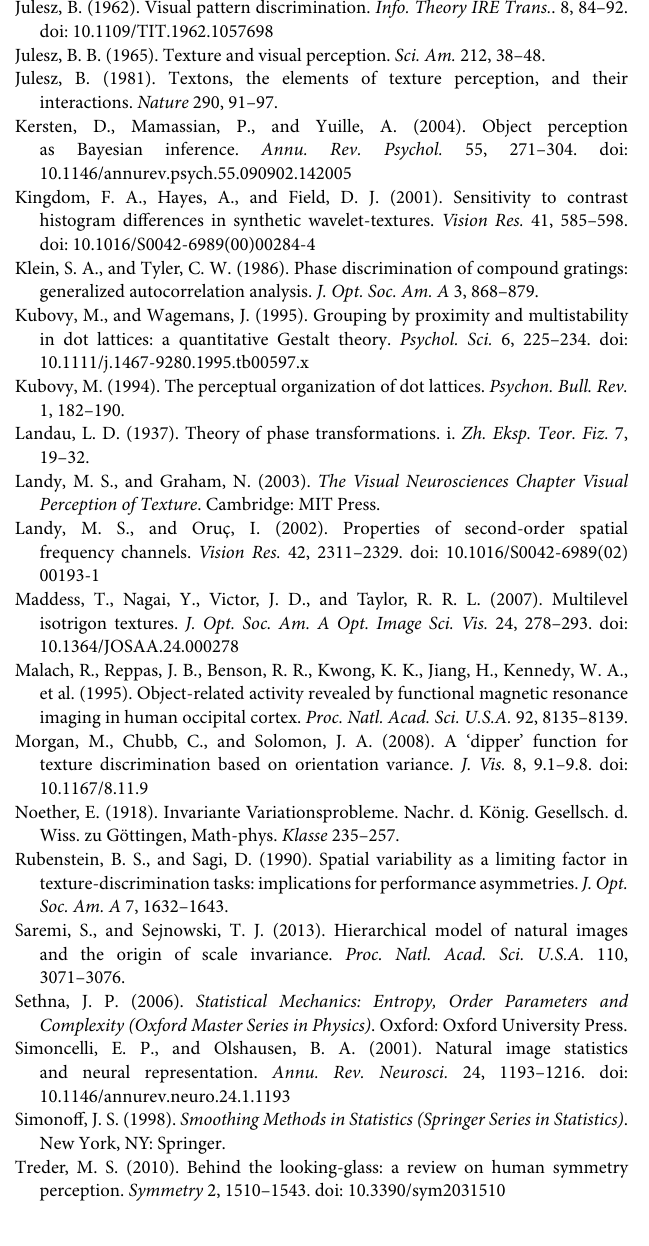
σ, θ , and λ are the width, orientation, and spatial frequency of the Gabor filter. The parameters used in the simulation are presented in Table 2 . The decision variable represents a sum of M -values over the corresponding